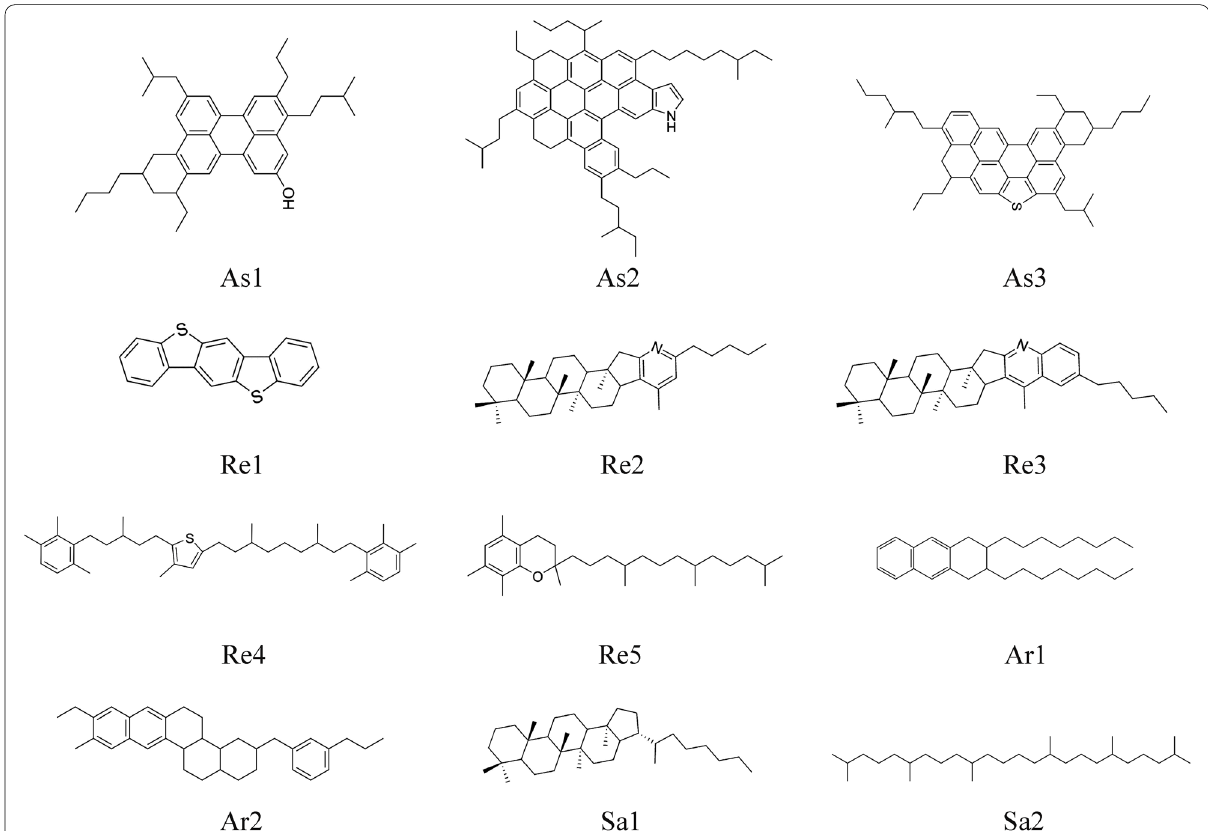
Fig. 1 12-Component Molecular Structures of Virgin Asphalt